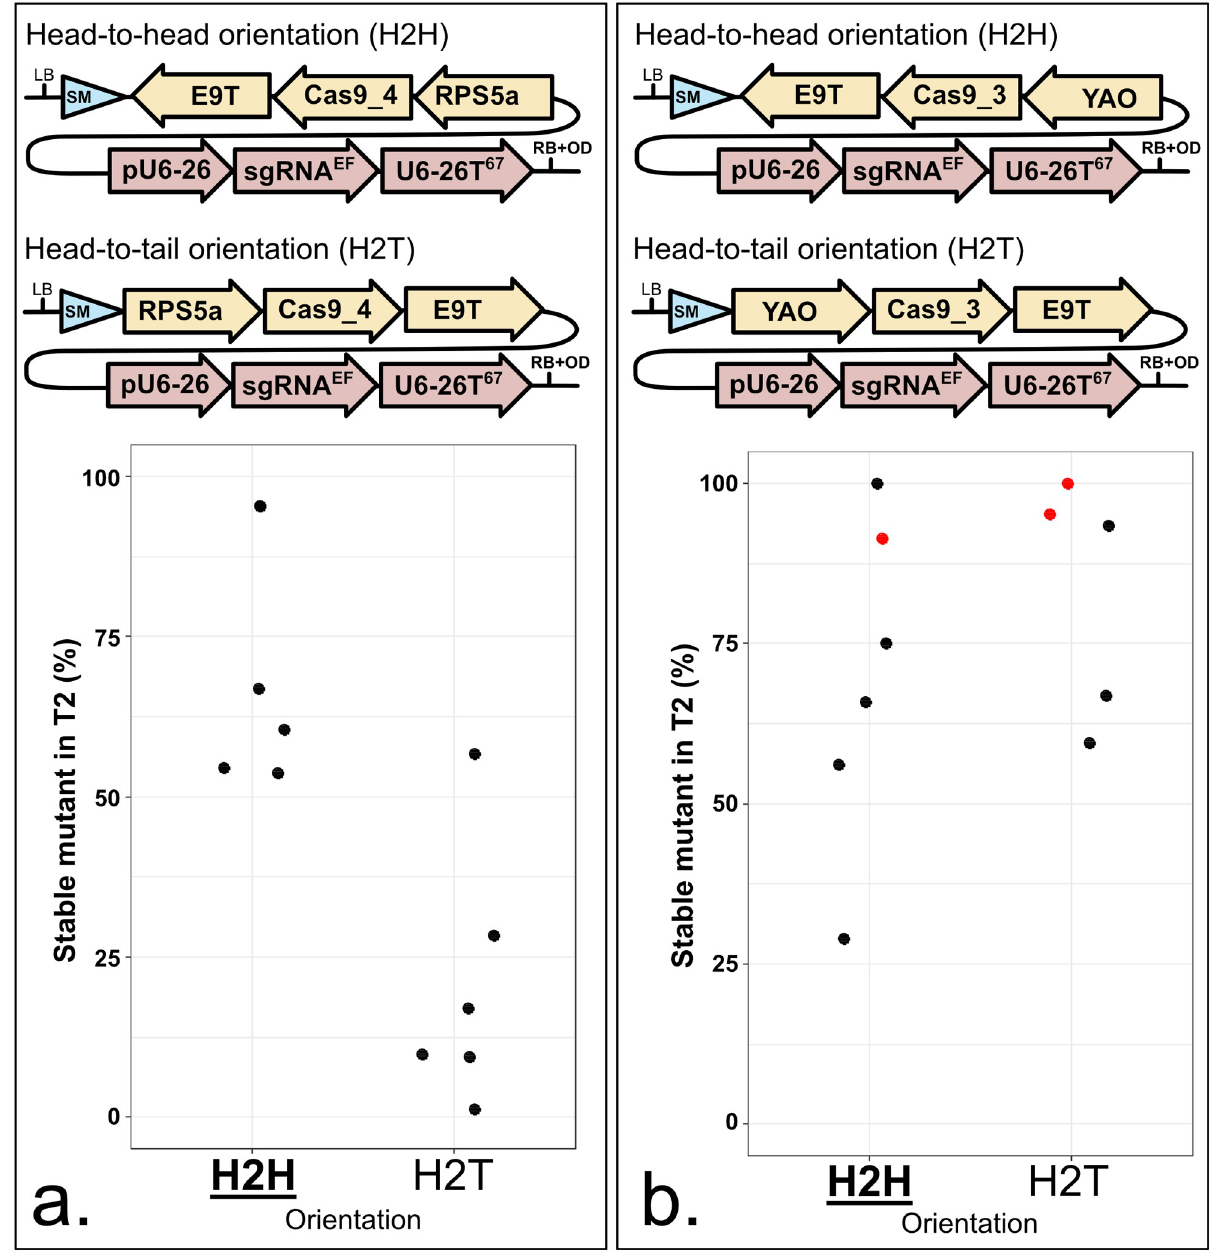
Fig 8. CRISPR activity is similar or higher when the sgRNA and the Cas9 expression cassettes are in a head-to-head orientation. a. and b. Each panel represents an orientation comparison in the same context. Orientations can be compared within each panel, not from one panel to another. The modules have been assembled by Golden Gate into pICSL4723 (RB+OD, with an overdrive ) and transformed into Col-0 via Agrobacterium tumefaciens strain GV3101. LB: Left Border. SM: Selectable Marker ( Glufosinate resistance gene. RPS5a: 1688 bp of the At3g11940 promoter. YAO: 596 bp of the At4g05410 promoter. Cas9_3: Li et al ., 2013 [25]. Cas9_4: Le Cong et al ., 2013 [10]. E9T: 631 bp of the Pisum sativum rbcS E9 terminator. U6-26p: 205 bp of the At3g13855 promoter. sgRNA EF : “extension-flip” sgRNA. U6-26T: 67 bp of the At3g13855 terminator. RB: Right Border. a. Five lines were tested for H2H instead of six. b. Five lines were tested for H2T instead of six. The sgRNA targets ADH1 . CRISPR activity measured in % of homozygous or biallelic stable mutants in the second generation after transformation (T2). Each dot represents an independent T2 family. Red dot: All the T2 lines from this family carry the same mutation, indicating a mutation more likely inherited from the T1 parent rather than being de novo from the T2 line. Bold and underlined: Most active construct(s) for each panel.